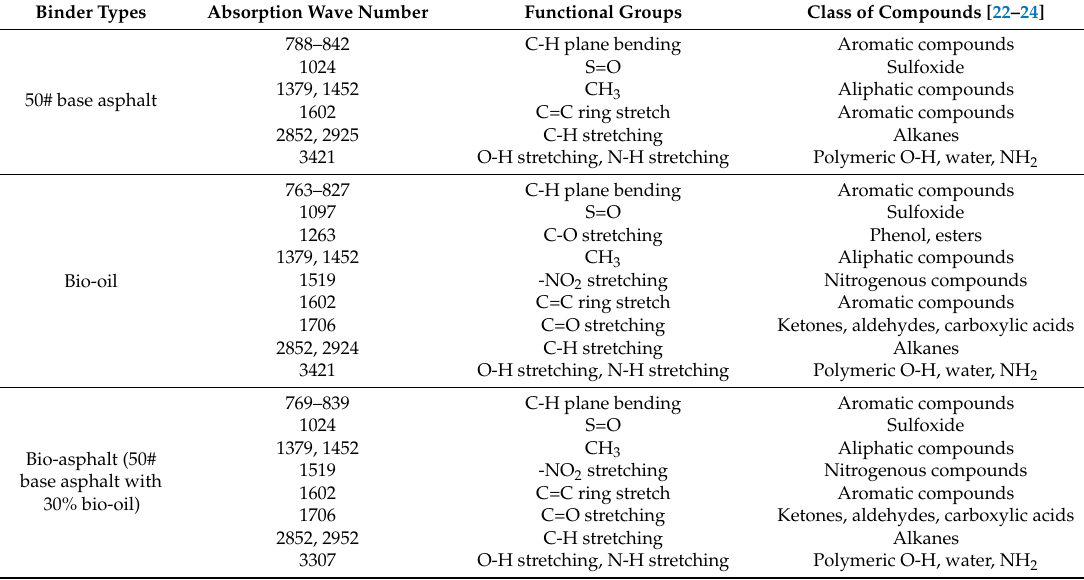
Table 4. Functional groups identified of three kinds of binders.